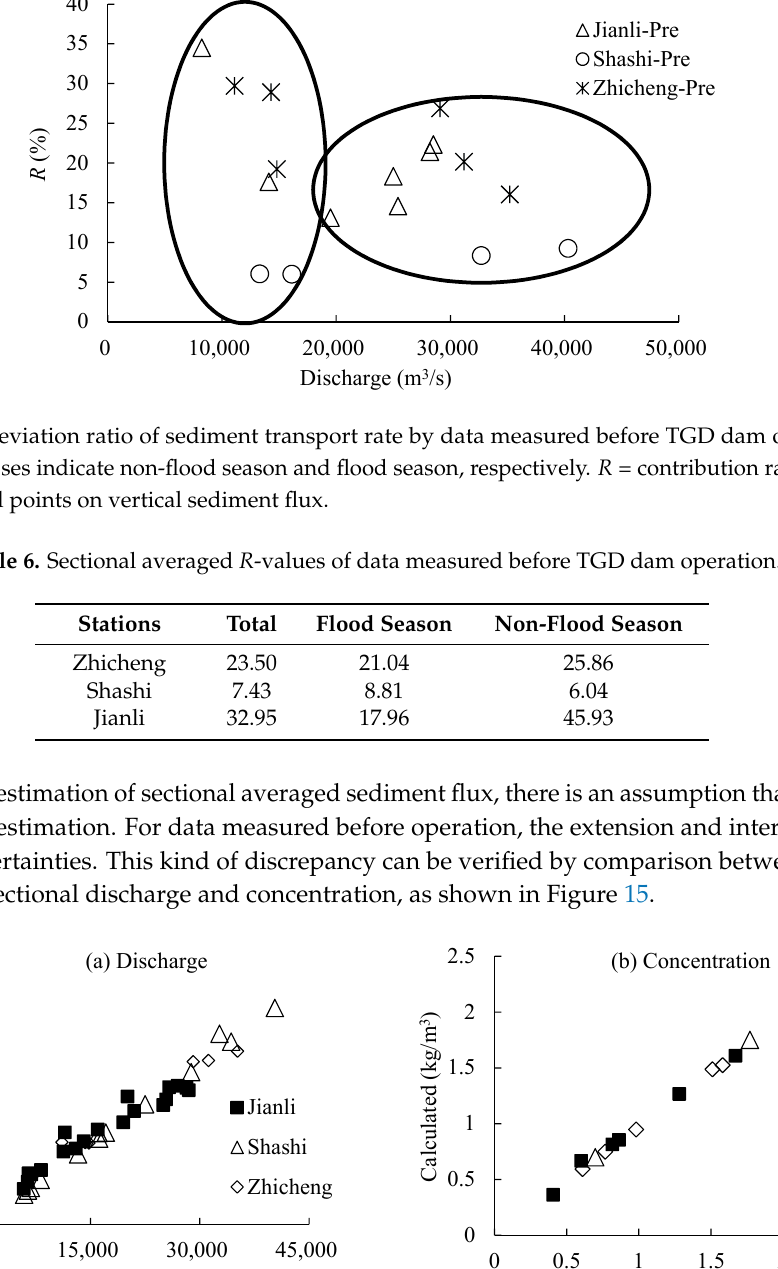
13 of 20 Figure 13. Bed load of Shashi ( a ) and Jianli ( b ) hydrological stations. Data in ( a ) were measured 9 July 1986 at Xinchang hydrological station, and 6 June 2013 at Shashi hydrological station; data in ( b ) were measured 26 May 1986 and 13 March 2013 at Jianli hydrological station. 4.1.2. Sediment Flux